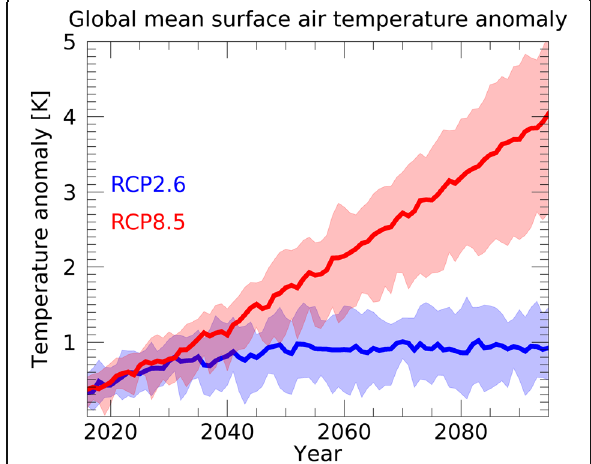
Fig. 1 Time sequence of the global mean surface air temperature anomaly given as atmospheric forcing to the land surface model. The width of the lines represents the maximum and minimum values of the simulated results forced by the five GCMs; the average value is represented by the bold lines. The global mean surface air temperature under RCP2.6 (blue) and RCP8.5 (red) scenarios is shown. Anomaly of surface air temperature is calculated with respect to the 1995 – 2014